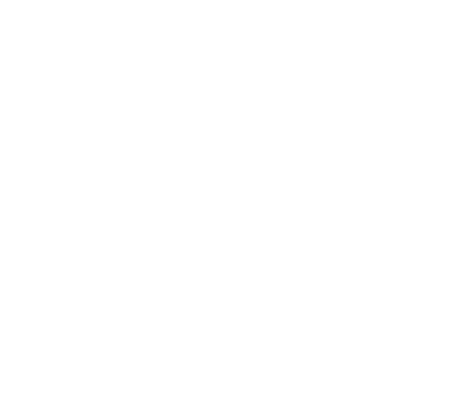
Figure 4. Effect of temperature on the activity of